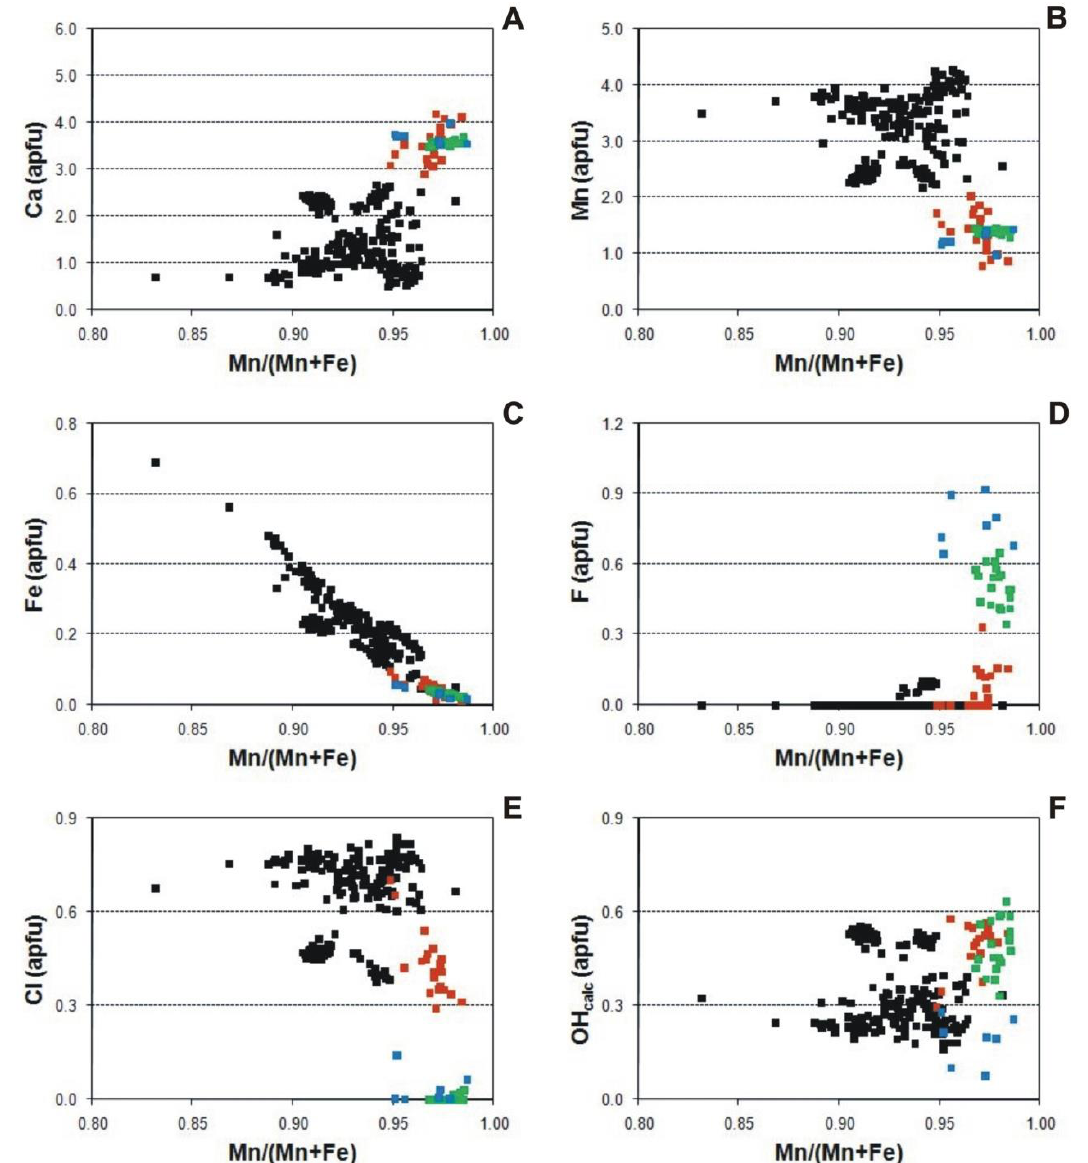
Figure 5. Dependences of Ca ( A ), Mn ( B ), Fe ( C ), F ( D ), Cl ( E ) and OH calc ( F ) on the Mn/(Mn + Fe) fractionation index in the structure of apatites from the Szklary pegmatite. Colours as in Figure 3. Type 4 apatites are out of scale of the figures with significantly lower values of Mn/(Mn + Fe).